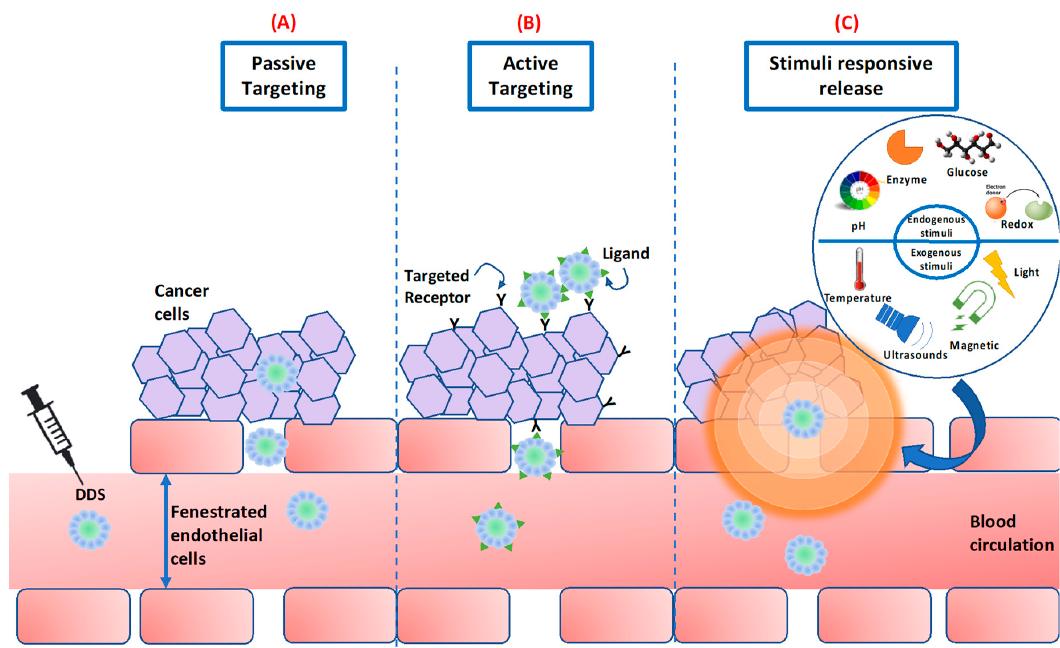
Figure 4. Targeting strategies of ATRA-loaded DDSs. Graphical representation according to targeting strategies: ( A ) passive targeting, ( B ) active targeting, and ( C ) responsiveness to endogenous and/or exogenous stimuli.